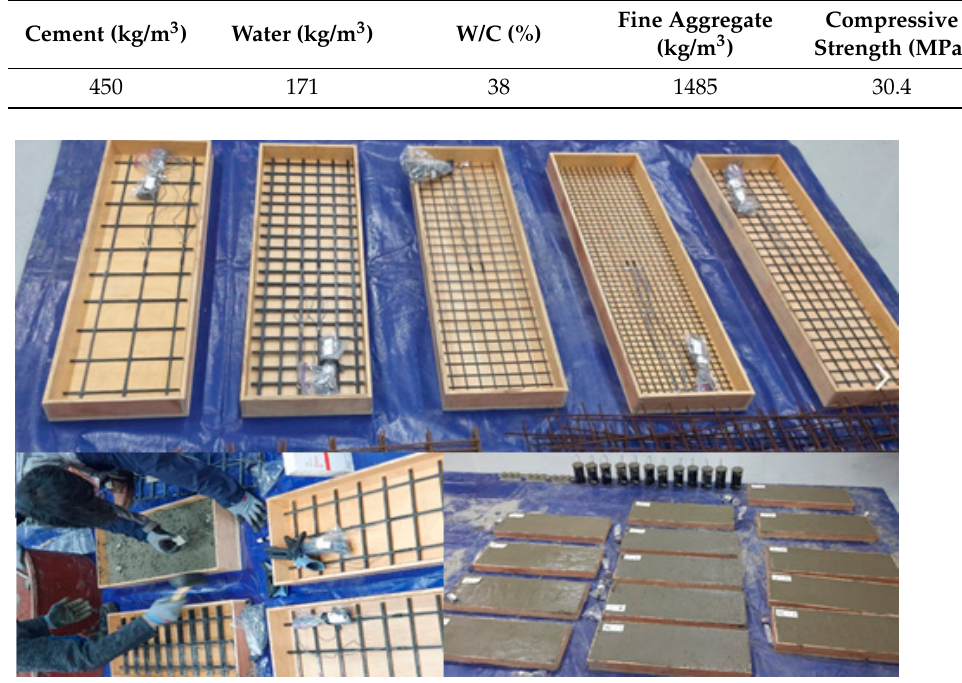
Figure 4. Manufacturing process for the specimens reinforced with carbon grids.